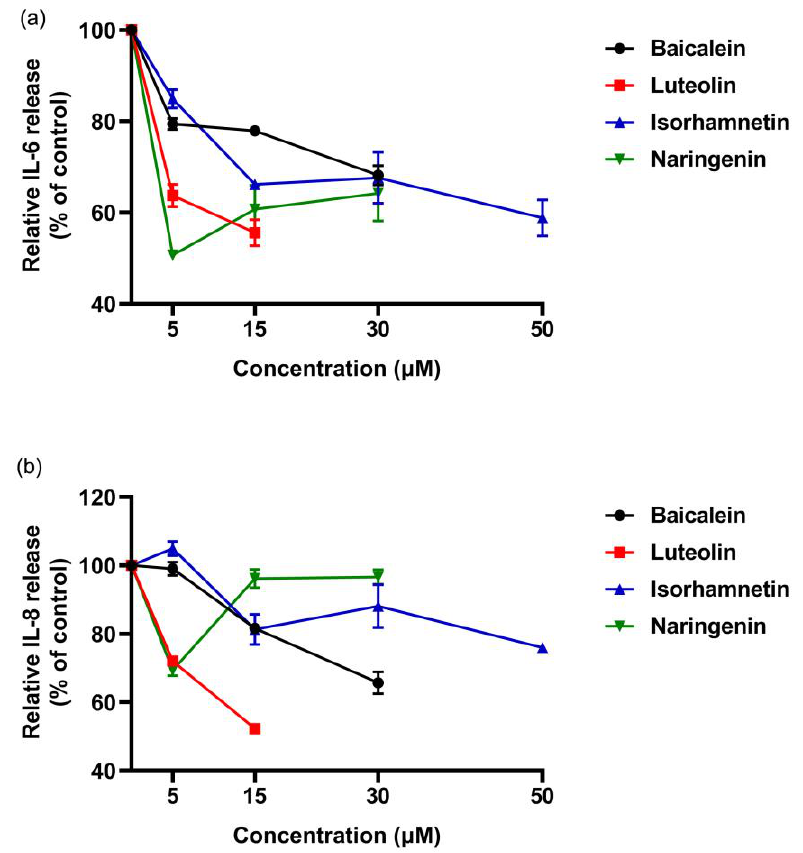
Figure 11. Dose-effect relationship of four flavonoids inhibiting IL-6 and IL-8 release from Caco-2 cells induced by ω -5 gliadin-derived peptide P4. ( a ) Dose-effect relationship of flavonoids for inhibition IL-6 release; ( b ) dose-effect relationship of flavonoids for inhibition IL-8 release. 3.10. Flavonoids Improved Intestinal Epithelial Tight Junction Damage Induced by ω -5 Gliadin-Derived Peptide ω -5 gliadin-derived peptide P4 promoted the release of zonulin (Figure 12), and re-